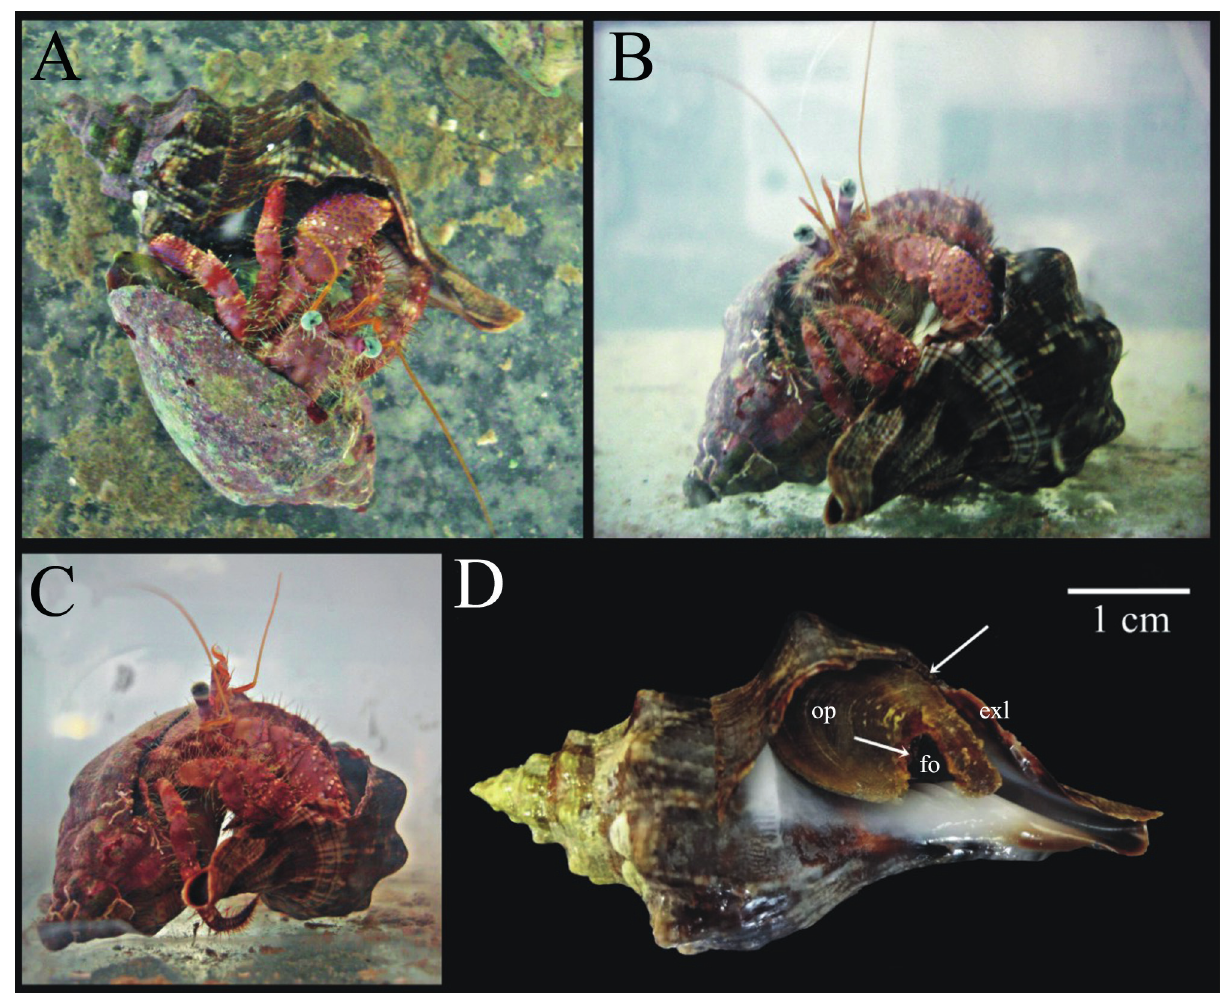
Figure 2. A–C, Sequence of attacks of Dardanus venosus on Aurantilaria aurantiaca ; D, damages in A. aurantiaca after the attack. White arrows indicates the damages in the operculum (op), foot (fo) and external lip